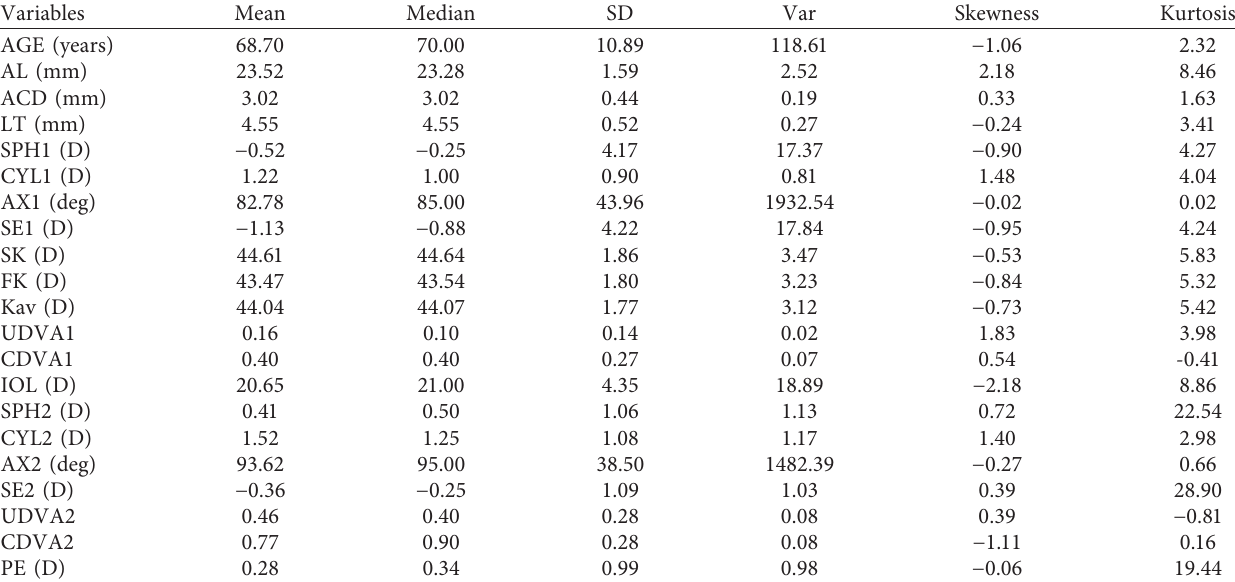
Table 2: Statistical parameters of the considered